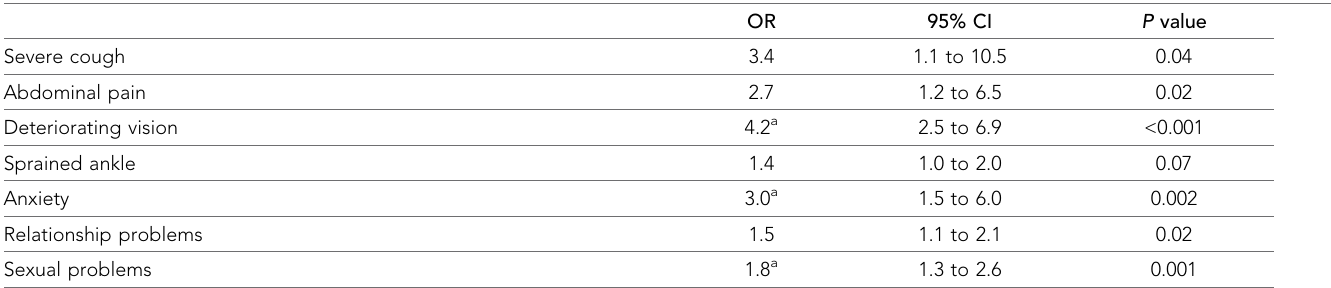
Table 4. Comparisons of patients’ and their GPs’ expectations regarding healthcare-seeking behaviour. Multiple logistic regression (GEE), corrected for patients’ age and sex, GPs’ age and sex, size of patient lists, and geographical location of practice. OR indicates the probability of the GPs answering Yes, with patients as reference